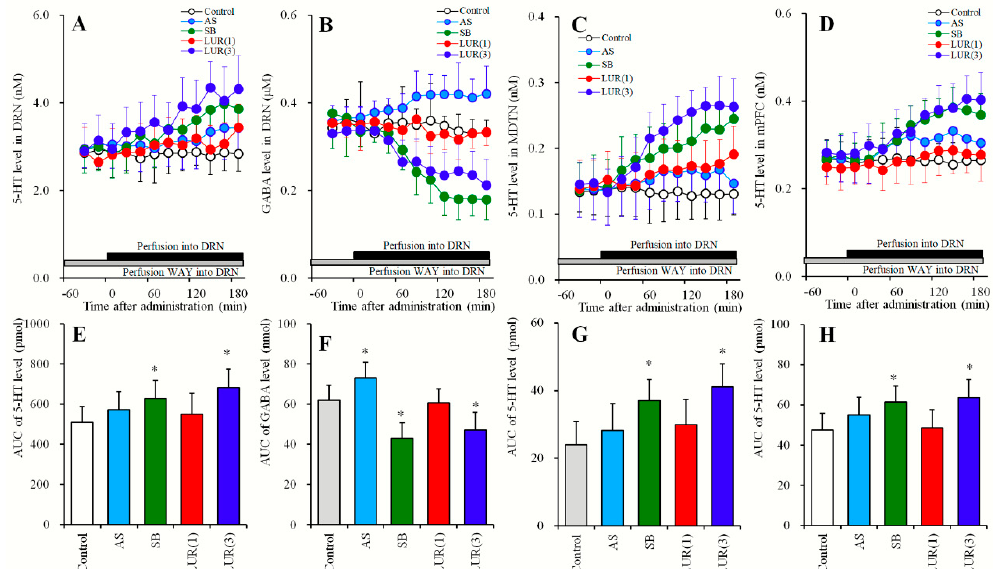
Figure 5. Effects of local administration of AS19, SB269970 and lurasidone into the DRN on extracellular levels of 5-HT in the DRN, MDTN, mPFC, and GABA in the DRN under the inhibition of 5-HT1AR in the DRN (Study_4). ( A ), ( C ) and ( D ) indicate effects of perfusion with AS19 (AS: 1 μ M), SB269970 (SB: 10 μ M) and lurasidone (LUR: 1 and 3 μ M) during perfusion with 10 μ M WAY100635 into the DRN on extracellular levels of 5-HT in the DRN, MDTN and mPFC, respectively. ( B ) indicates effects of perfusion with AS19, SB269970 and lurasidone into the DRN during perfusion with WAY100635 on extracellular GABA level in the DRN. Y -axis: mean ± SD (n = 6) of extracellular levels of 5-HT (nM) and GABA ( μ M); X -axis: time after administration of target agents (min). Closed bars indicate perfusion with target agents, and gray bars indicate perfusion with WAY100635. Microdialysis was conducted to measure the releases of 5-HT and GABA. ( E ), ( F ), ( G ) and ( H ) indicate the AUC value of extracellular levels of 5-HT (pmol) and GABA (nmol) during perfusion with target agents from 20 to 180 min of ( A ), ( B ), ( C ) and ( D ), respectively. Opened, light blue, green, red and blue columns represent the AUC values of perfusion with control, AS19, SB269970, 1 μ M and 3 μ M lurasidone, respectively. * P < 0.05; relative to control by MANOVA with Tukey’s post hoc test.